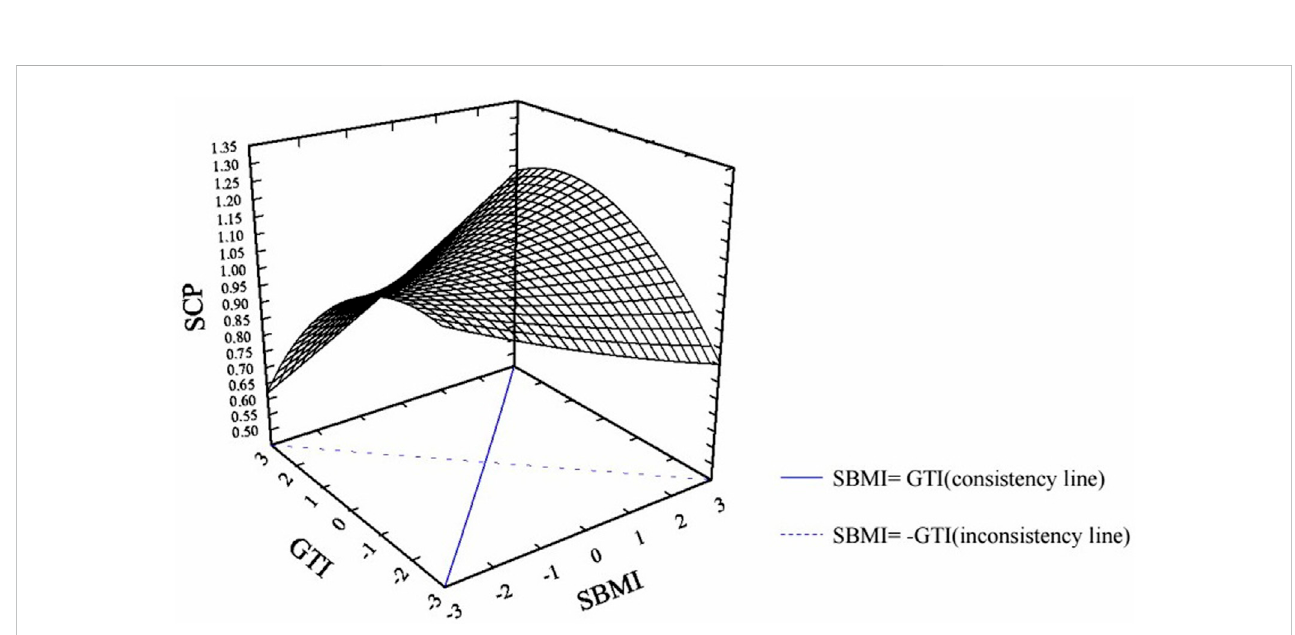
FIGURE 8 Surface graph of SBMI-GTI consistency/inconsistency on SCP, when the degree of corporate strategic aggressive is low.